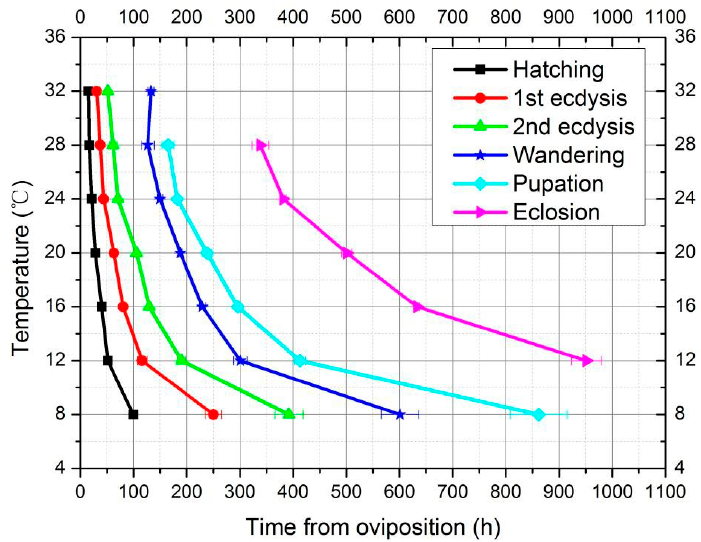
Figure 3. Isomorphen diagram of A. grahami. The duration (h) of each developmental event (hatching, first-ecdysis, second-ecdysis, wandering, pupation, and eclosion) plotted with the time from oviposition to the onset of each event. Each curve corresponds to a developmental event, and the error bar is the standard deviation of the time for each event.